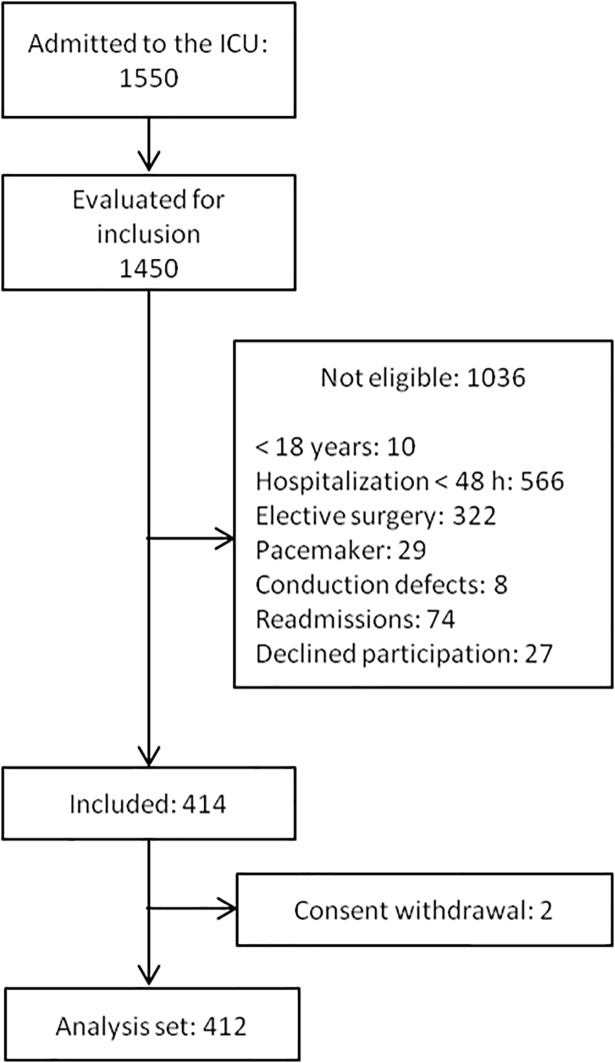
Patient accountability.